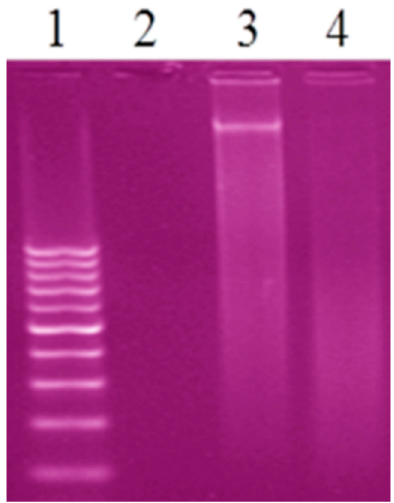
Figure 8. Gel electrophoresis image of the interaction of CT-DNA with the new complexes, Lane 1: 100 DNA ladder, Lane 2: CT-DNA + PdL, Lane 3: CT-DNA + AgL, Lane 4: CT-DNA + CuL.